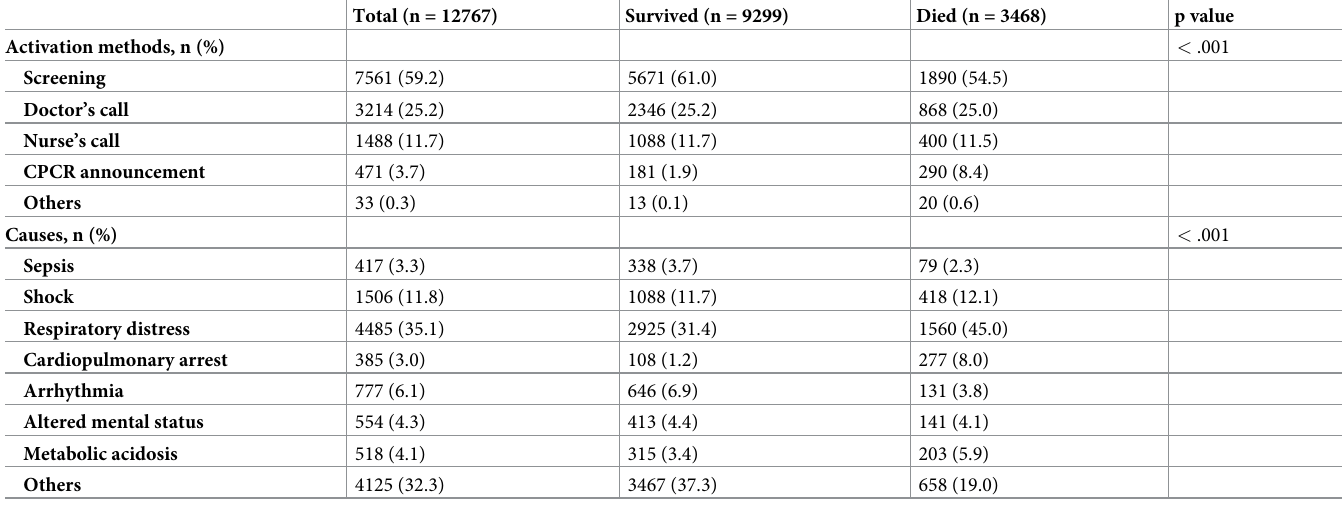
Table 2. Medical emergency team activation methods and